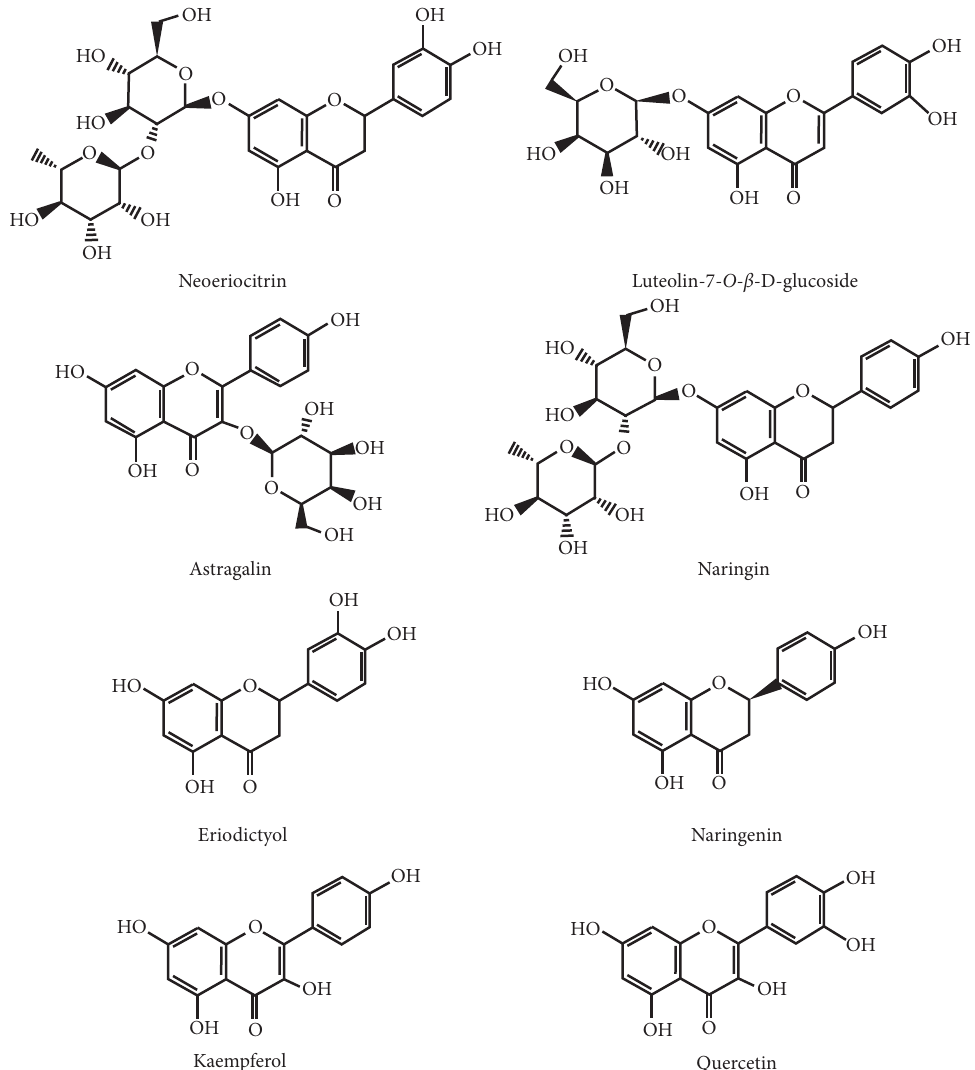
Figure 1: Chemical structures of seven analytes and